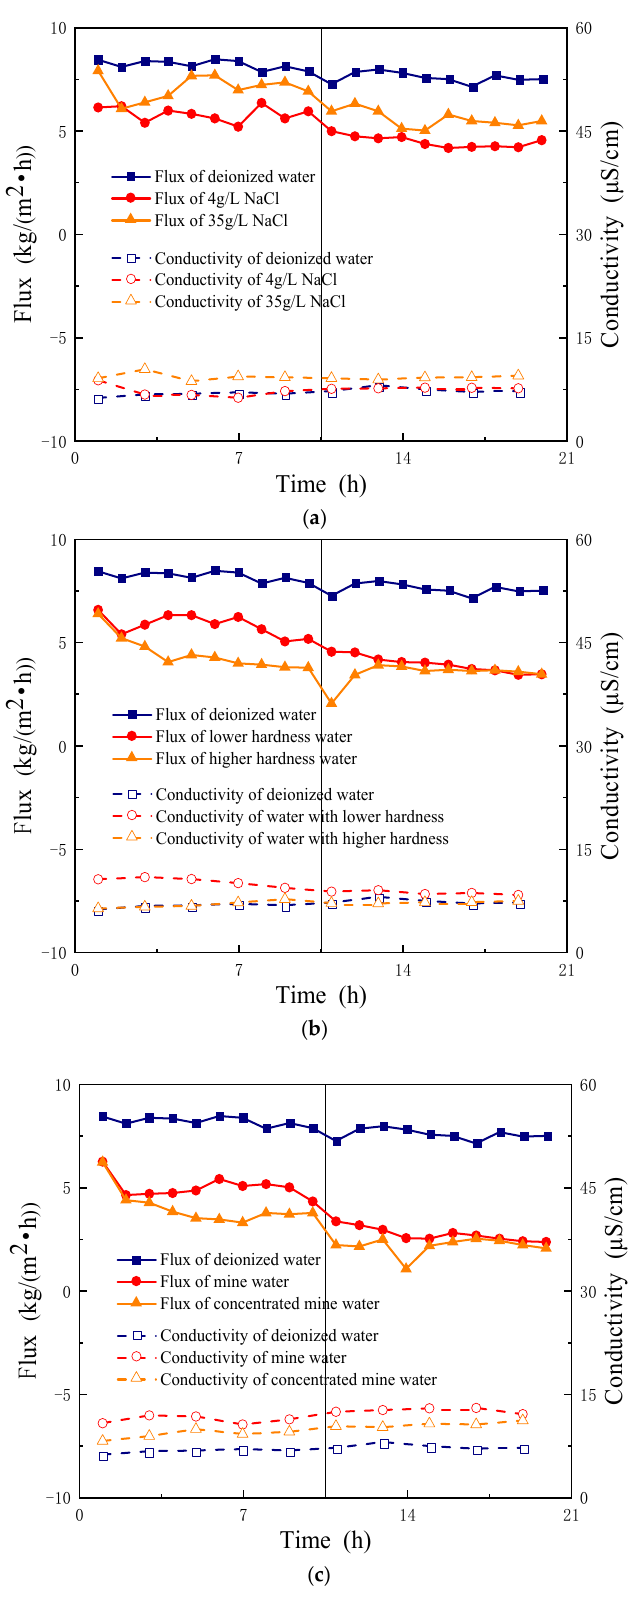
Figure 13. Flux and conductivity variation of the PVDF-H membrane in the treatment of ( a ) NaCl solution with different concentrations, ( b ) solution with different calcium–magnesium hardness, ( c ) mine water and concentrated mine water by DCMD.